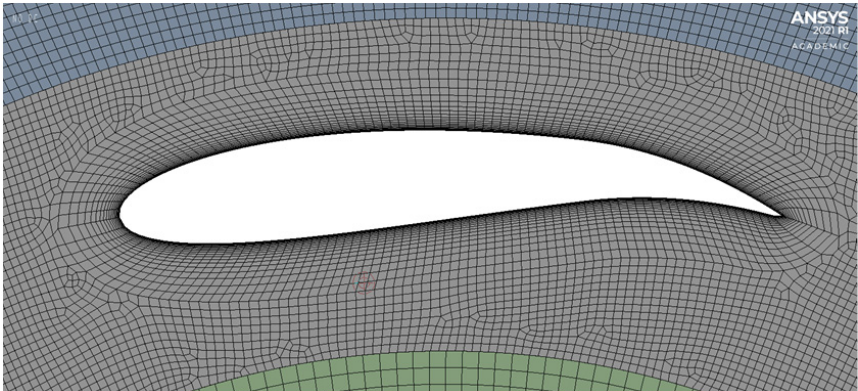
Figure 3. Mesh around a blade.